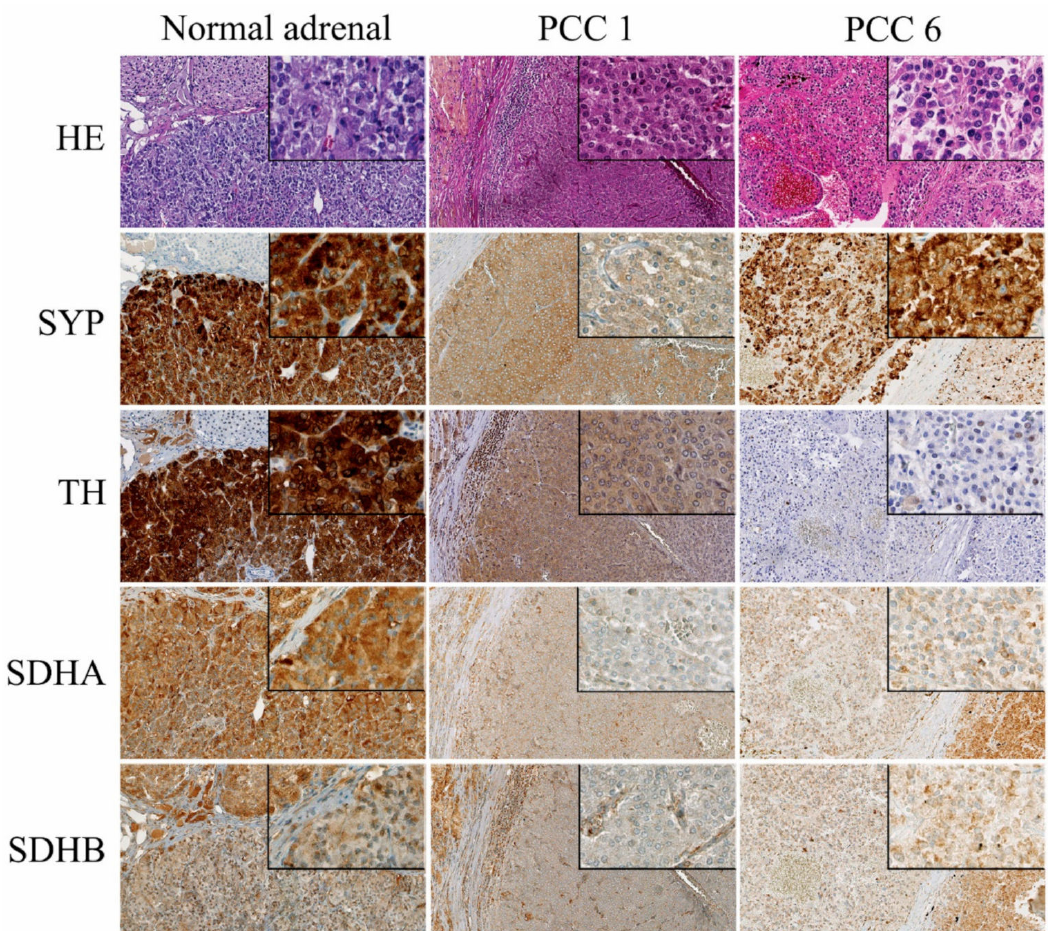
Figure 2. Hematoxylin Eosin staining and immunohistochemistry for synaptophysin (SYP), tyrosine hydroxylase (TH), succinate dehydrogenase subunit A (SDHA) and subunit B (SDHB) of normal dog adrenal, PCC1, and PCC6. Normal adrenal glands were used as positive controls and show strong expression of SYP and tyrosine hydroxylase (TH). PCC1 and 6 label weakly positive for SYP, but for TH only PCC1 shows positive labeling. The normal canine adrenal gland labels positive for SDHA and SDHB, although there is lack of granular labeling, which is characteristic for SDHA and SDHB in human tissues. PCC1 shows labeling of the stromal cells for SDHA and SDHB, which serve as positive control cells, while the PCC cells appear to be heterogeneous weak / negative for SDHB and do not label for SDHA. PCC 6 showed heterogeneous weak expression of SDHB, but there was no di ff erence in labeling intensity between the tumor cells and the normal stromal cells for SDHA. Pictures are at 20 × magnification, internal boxes at 40 ×